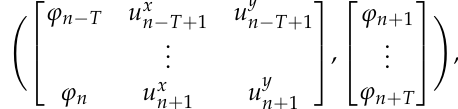
Figure 9. Input ϕ ( top row ), N 10